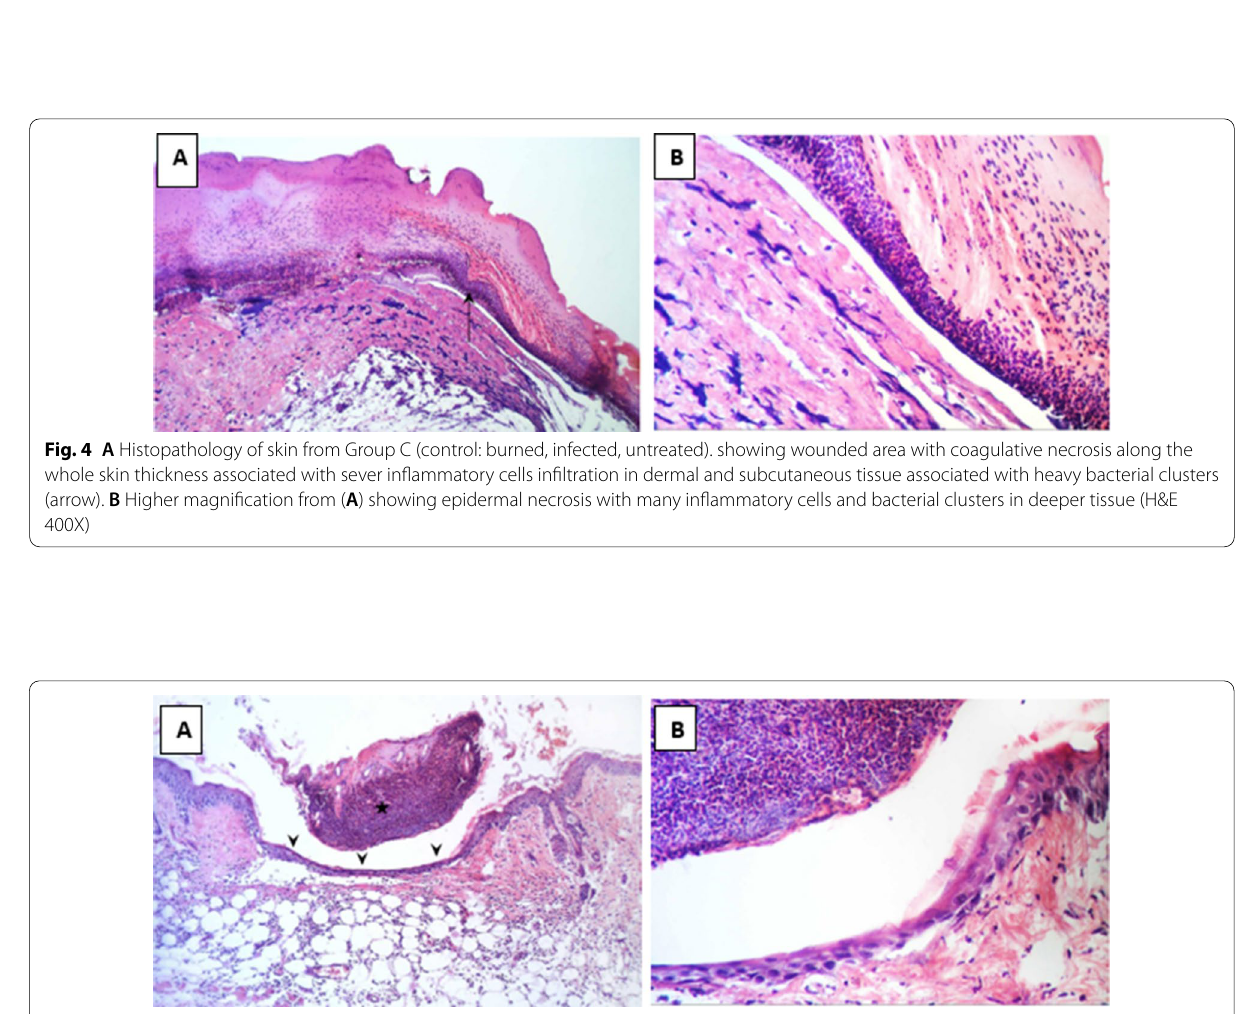
Fig. 5 A Histopathology of skin from Group 1 (test: burned, infected, treated with Ahl-1 hydrogel) Showing complete epithelial cells bridging (arrow head) the wound gap under crust from necrotic tissue debris and inflammatory cells (star), inflammatory cells infiltration in dermal, subcutaneous fat layer with many activated fibroblasts. B Higher magnification from ( A ) showing complete epithelial cells bridging the wound gap under necrotic tissue with newly formed collagen fibres in underlying dermis (H&E